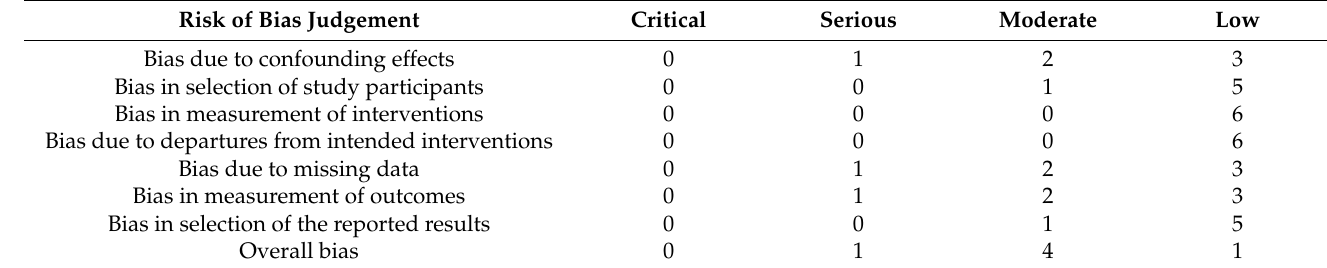
Table 6. Risk of bias judgment outcomes of the RCT studies (n = 6).